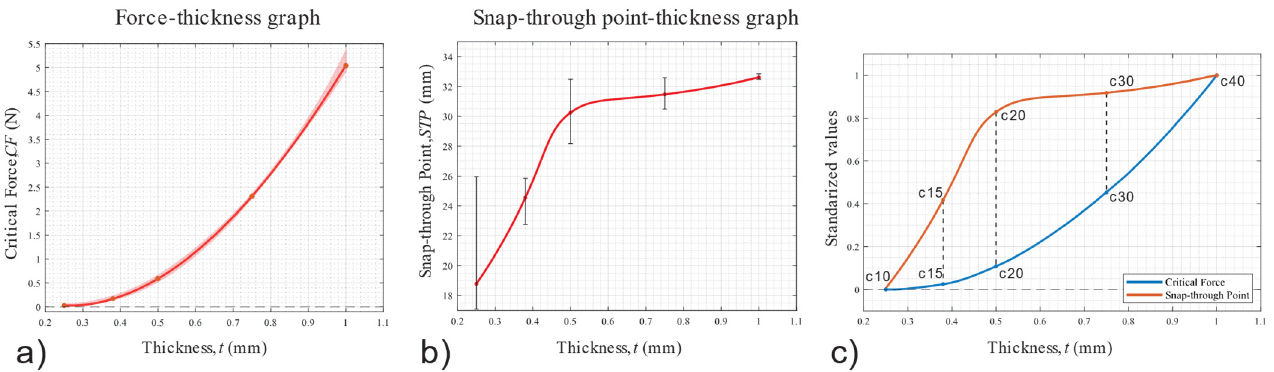
Figure 6. ( a ) The force-thickness graph exhibits a non-linear relationship ( b ) The snap-through point-thickness plot demonstrates that thicker flexure beams snap at longer distances. ( c ) Plot that exhibits the opposite growth of the critical force and snap-through point curves as a function of